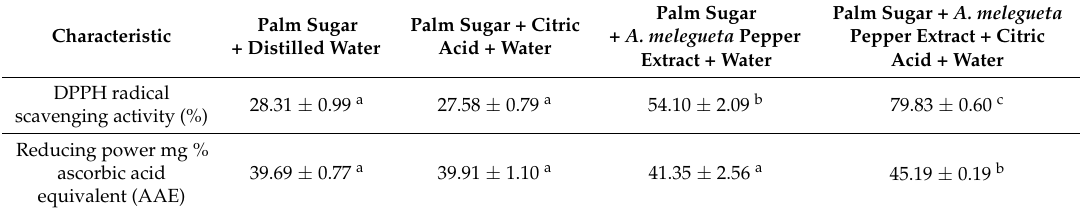
Table 7. Antioxidant capacity of beverage